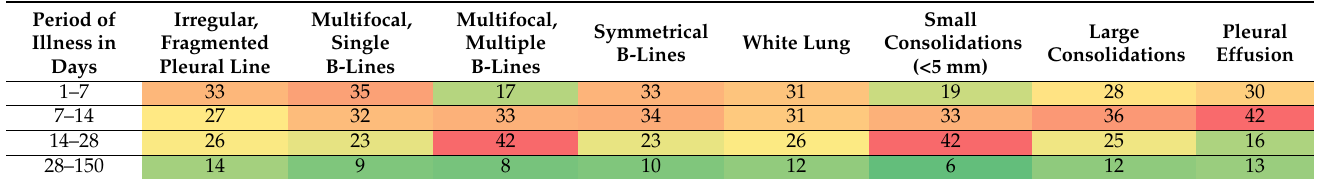
Table 3. Summarized incidence of specific LUS findings depending on the period of